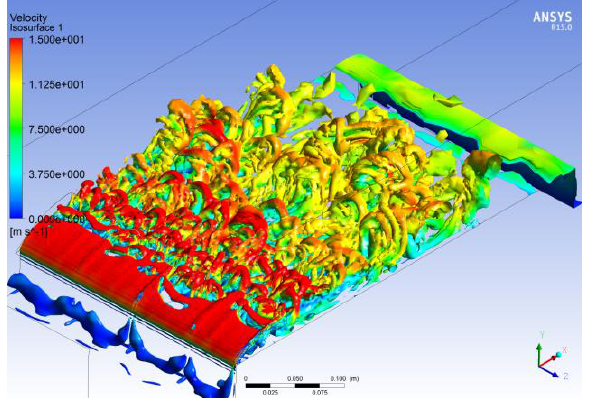
Fig. 10. The turbulent flow structure around a model obstacle (velocity contour lines).